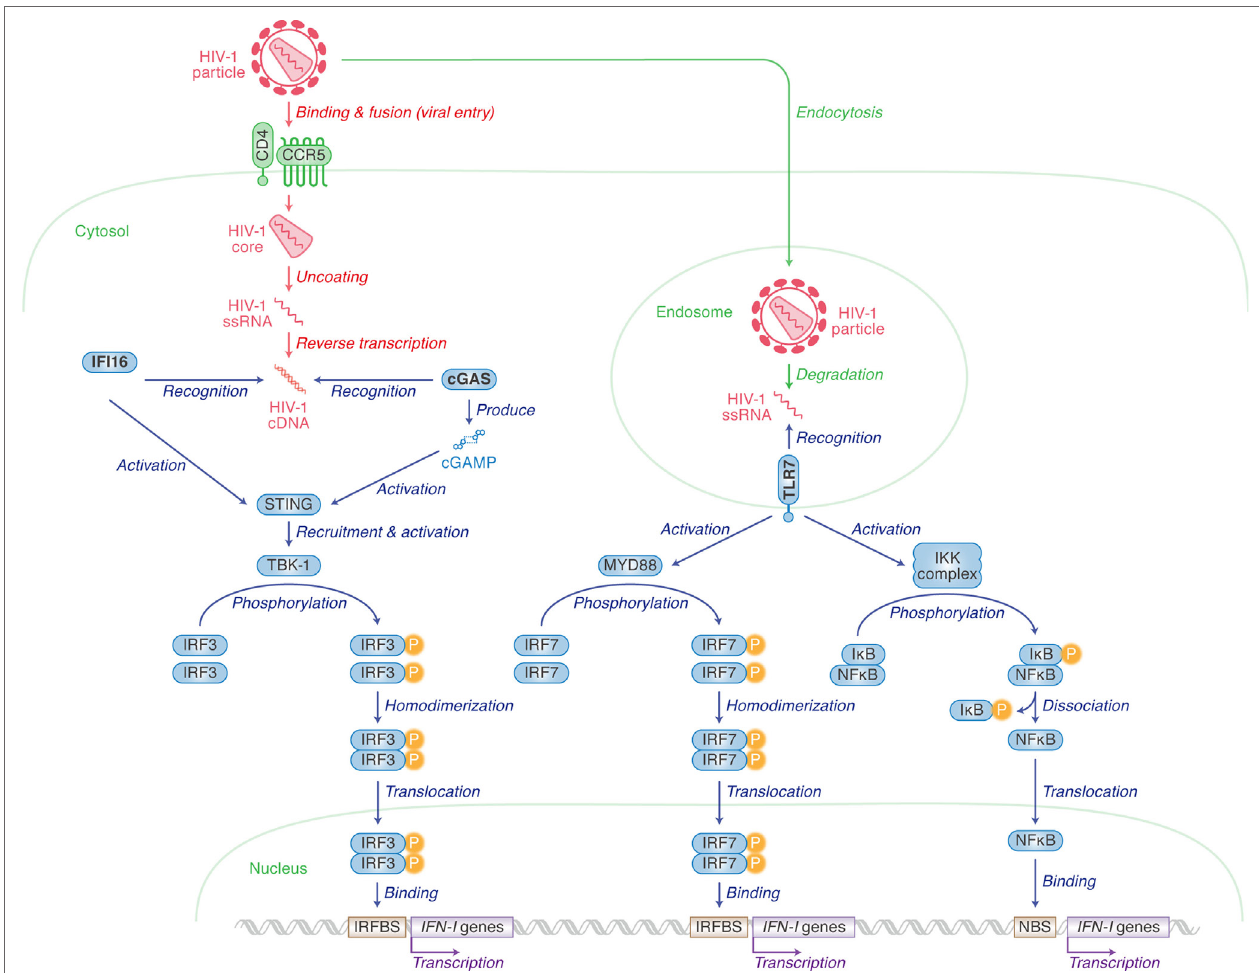
FiGURe 1 | Pattern recognition receptors (PRRs) for human immunodeficiency virus type 1 (HIV-1) recognition and the following pathway for triggering type I interferon (IFN-I) expression. Cellular actions are indicated in green (in italic) with arrows, and viral replication steps are indicated in red (in italic) with arrows. Cellular actions triggered by PRRs [IFN- γ inducible protein 16 (IFI16), cyclic GMP-AMP synthase (cGAS) and toll-like receptor 7 (TLR7)] are indicated in blue (in italic) with arrows. Cellular organelle, viral components, and sensor-related molecules are indicated in green, red, and blue, respectively. “P” with yellow circle indicates phosphorylation. The detail of each step is described in the main